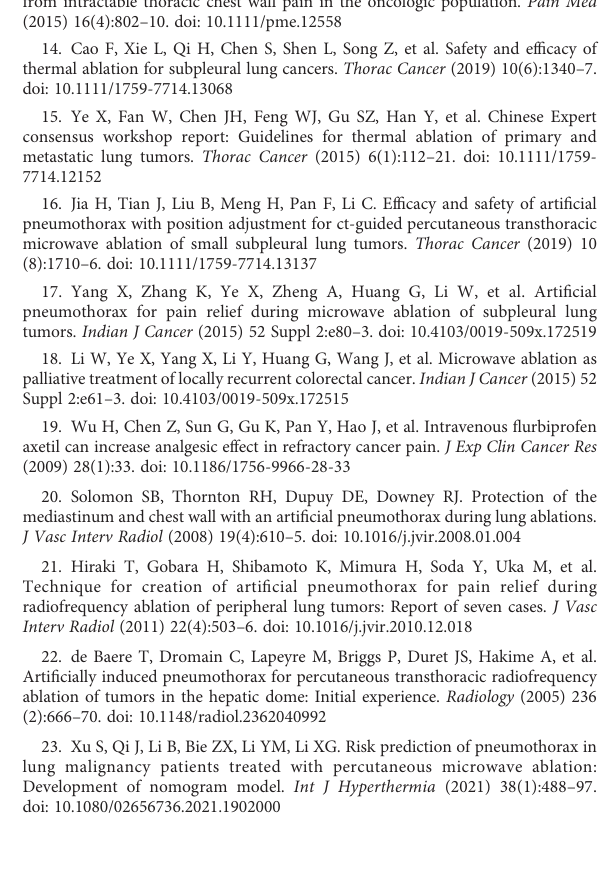
SUPPLEMENTARY TABLE 1 Differences of VAS in the peri-operative periods in each group.